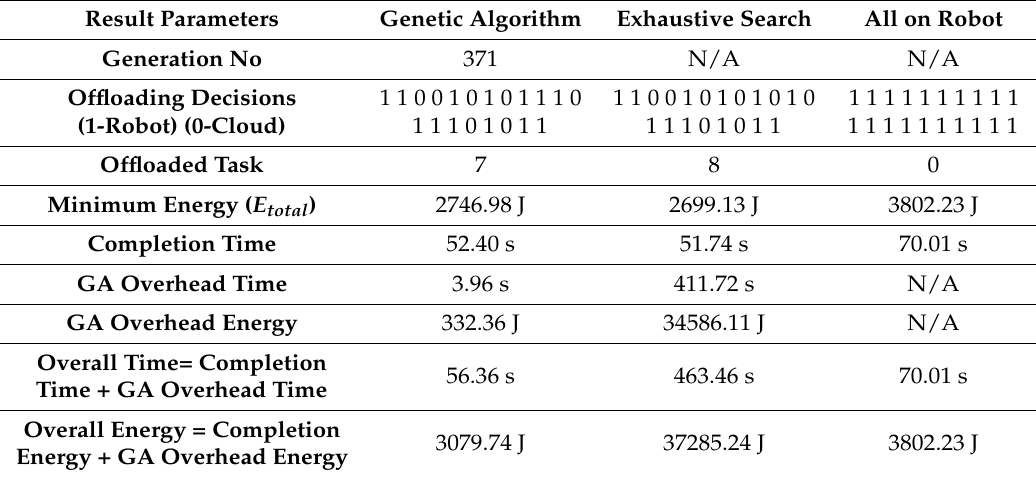
Table 3. Performance comparison for 20-node task flow (Minimise: E total